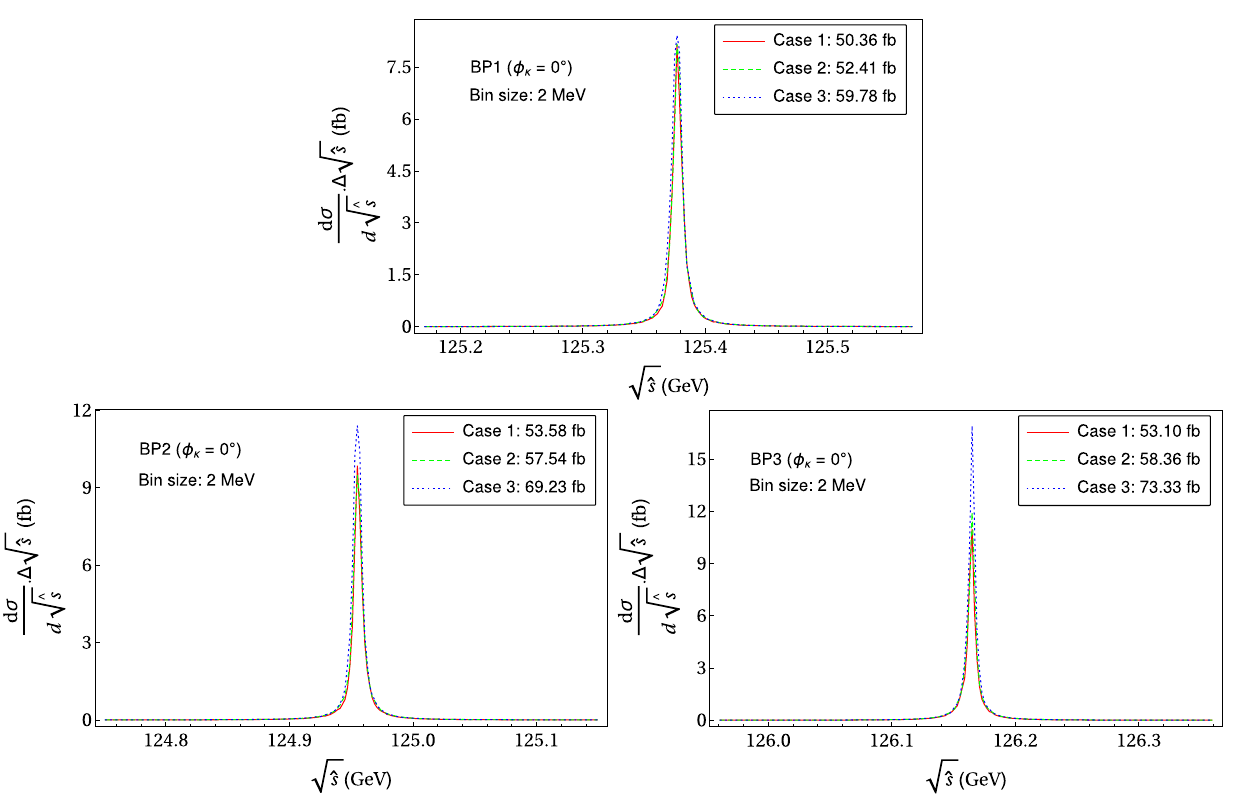
√ ˆ s ) for the three benchmark and (cid:15) H 1 2